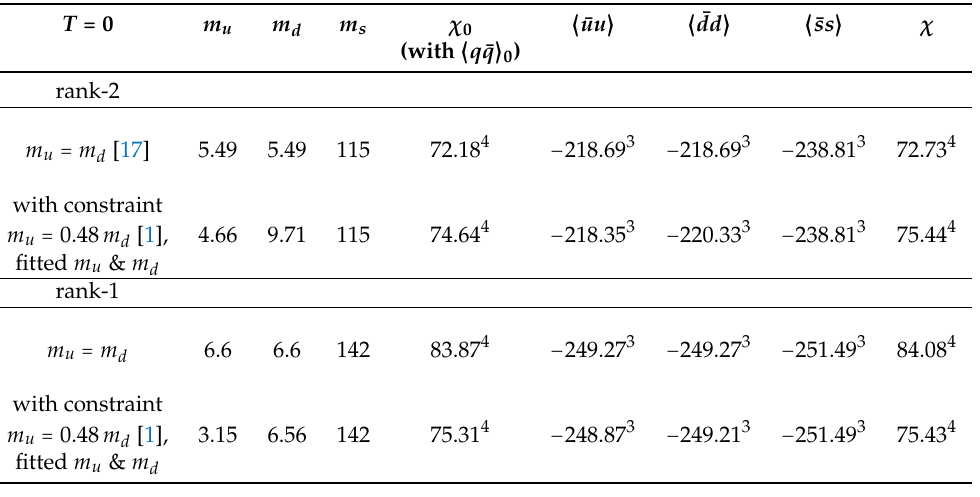
Table 1. For the both variants of the DSE separable model (with the rank-2 and rank-1 interaction Ansatz) used in the present paper, various sets of values of the model quark-mass parameters m q ( q = u , d , s ) are related to the model results for the topological susceptibility χ and the “massive" condensates ⟨ ¯ q q ⟩ at T = 0. The topological susceptibility χ varies because of varying m q and (to a much lesser extent) because of the changes of “massive" condensates induced by changes of the quark-mass parameters m q . The massless-quark condensate, ⟨ ¯ q q ⟩ 0 , depends only on the dynamical DSE model: always ⟨ ¯ q q ⟩ 0 = − 216.25 3 MeV 3 for the rank-2 model, and ⟨ ¯ q q ⟩ 0 = − 248.47 3 MeV 3 for the rank-1 model. Thus, the topological susceptibility χ 0 calculated with the chiral-limit condensate, varies for a given model only because of varying values of m q . All values are in MeV (or the indicated 3rd or 4th powers of